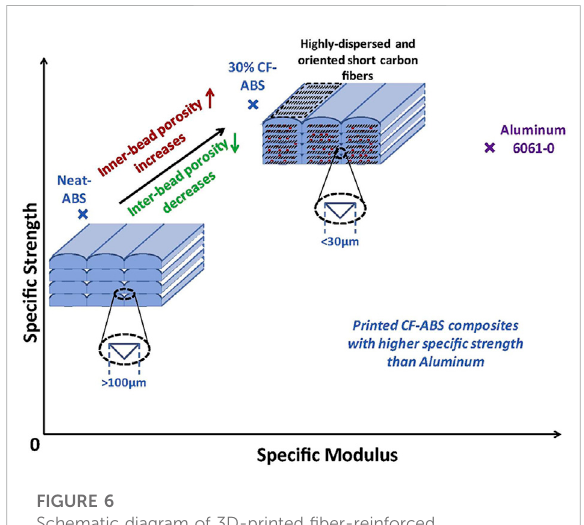
FIGURE 6 Schematic diagram of 3D-printed fi ber-reinforced composite by Fused Filament Fabrication. Copyright 2014,